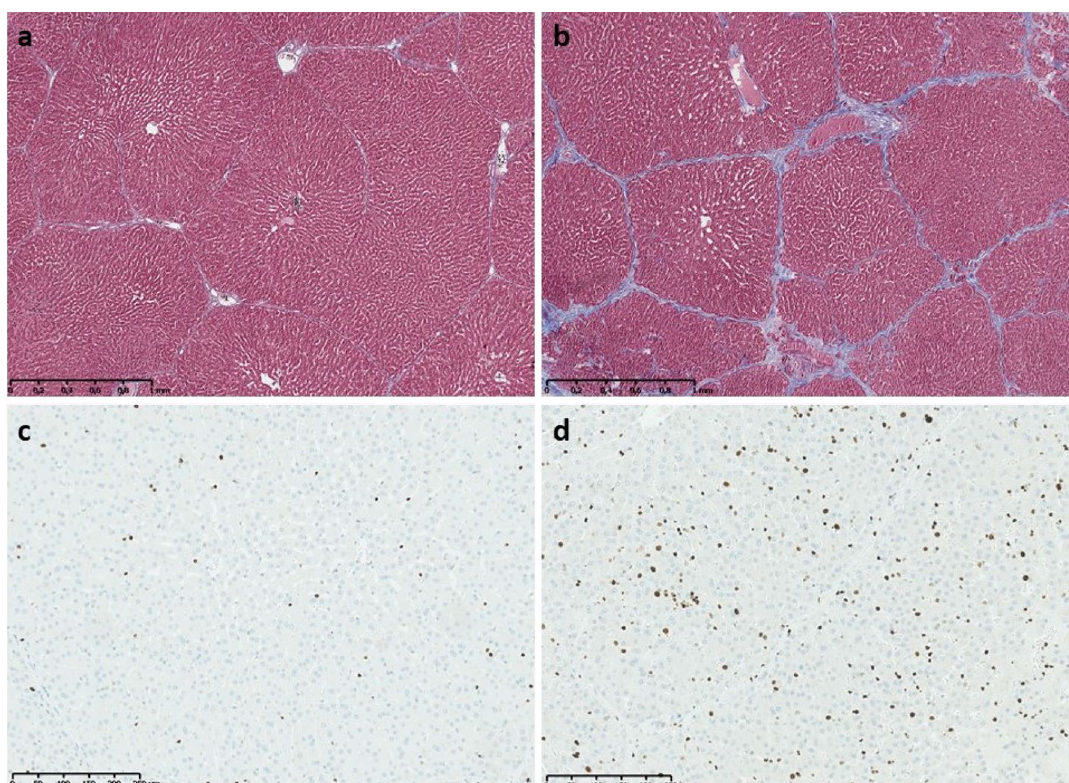
Figure 4. Histological images from a control pig (Pig C4; a , c ) and an irradiated pig with hepatic fibrosis (Pig R1; b , d ). ( a , b ) Tissue samples sections stained with Masson’s trichrome stain for evaluation of hepatic fibrosis in a control pig ( a ) and an irradiated pig ( b ) with mild fibrosis. ( c , d ) Tissue sections immunohistochemically stained with an antibody against the nuclear antigen Ki-67, specific for hepatocytes in the proliferating phases of the cell cycle. When compared with the control pig, the number of proliferating hepatocytes in the irradiated pig ( d ) is markedly higher.